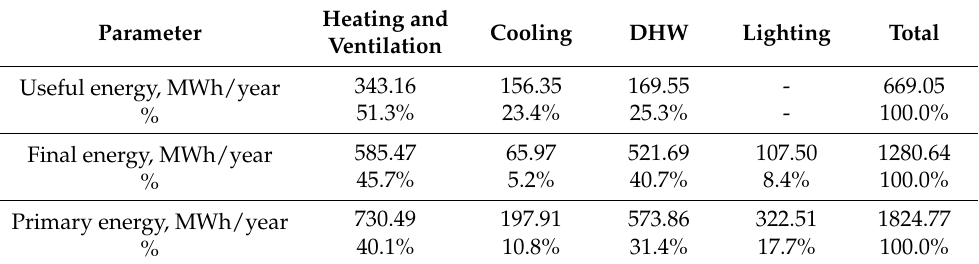
Table 4. Heat demand calculations—variant